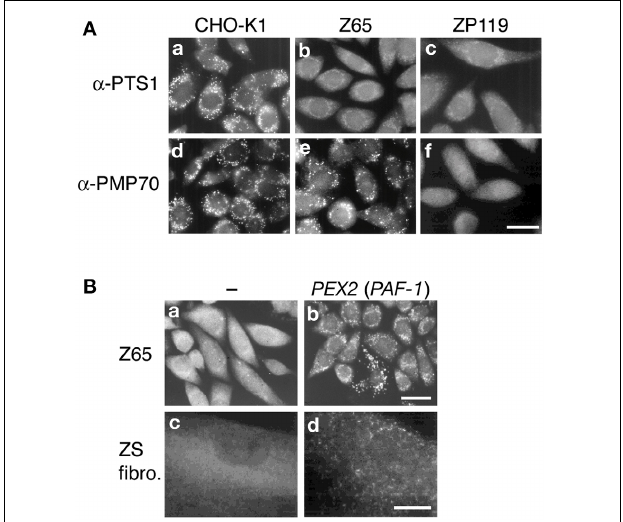
FIGURE 1 | Morphology of peroxisomes in CHO cell mutants defective in peroxisome biogenesis and cloning pathogenic genes of PBDs. (A) Cells are stained with antibodies to PTS1 (a–c) and PMP70 (d–f) . Cells are as indicated at the top. Scale bar, 20 μ m. In contrast to the wild-type CHO-K1 cells, PTS1 proteins are discernible in the cytosol in pex2 Z65 and pex19 ZP119. Z65 contains PMP70-positive peroxisomal remnants, whilst ZP119 is absent from such peroxisome ghosts, indicative of the defect of membrane protein import. (B) Cloning of pathogenic gene of PBD. Peroxisome-restoring PEX gene were isolated by functional complementation assay using CHO mutant. Restoration of peroxisomes in Z65 (a) by transfection of rat liver cDNA library (b) . Transformed cells positive in catalase import contained PAF-1 ( PEX2 ). In fibroblasts from a